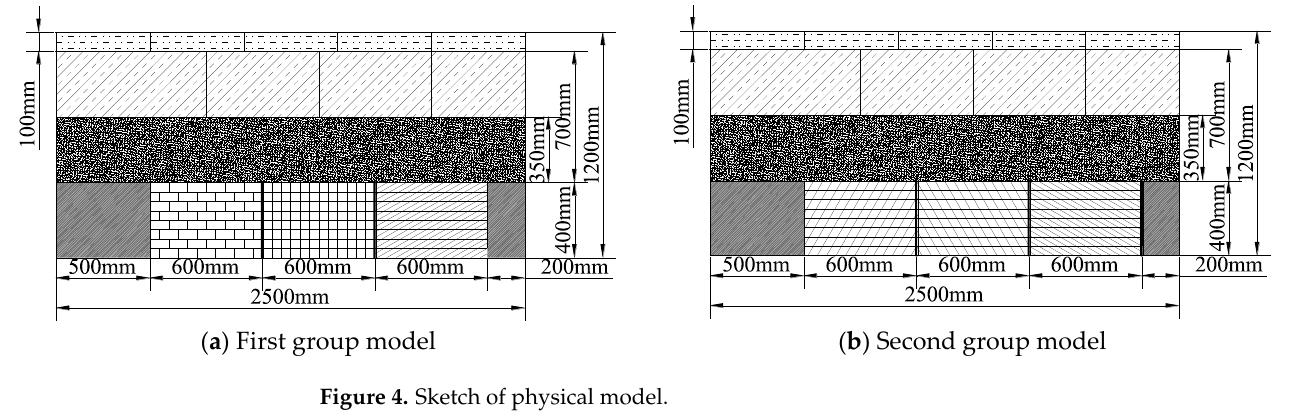
Figure 4. Sketch of physical model.